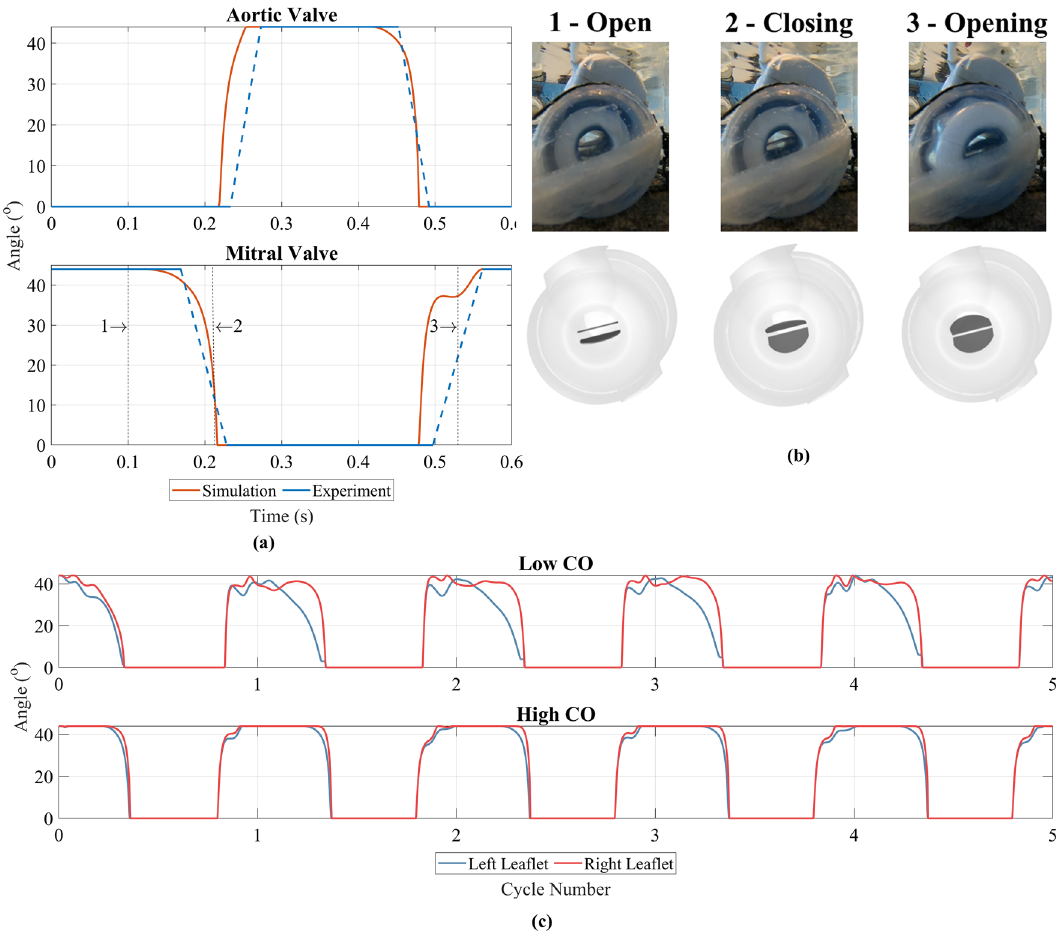
Figure 5. ( a ) Transient comparison of the aortic and mitral valve angles between simulated and in vitro data. The simulated left valve angle was used in both cases. Solid blue lines represent fully open and fully closed. Dashed blue lines represent the transition between the two states and not actual valve motion characteristics. ( b ) Image comparison between the in vitro video capture and simulated mitral valve position. Numbered points correspond to points on ( a ), where point 1 is mitral valve fully open, point 2 is during closing of the mitral valve and point 3 is during opening of mitral valve. Mitral valve leaflets are shown in dark grey, whilst light grey is rest of pump housing. ( c ) Comparison of the left and right mitral valve leaflets for the lowest CO (60 bpm 19 mm) equating to 3 L/min, and the highest CO (120 bpm 25 mm) equating to 7 L/min, where 0 ◦ is fully closed and 44 ◦ is fully